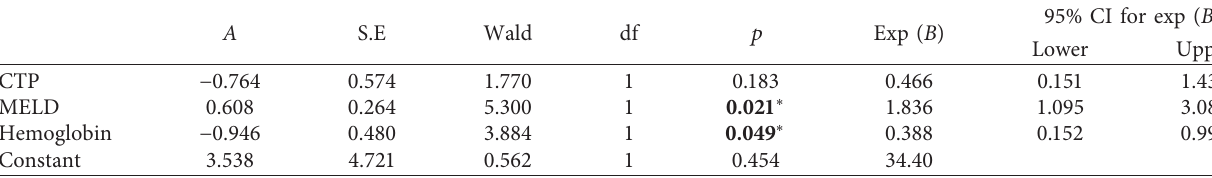
Table 4: Logistic regression analysis.